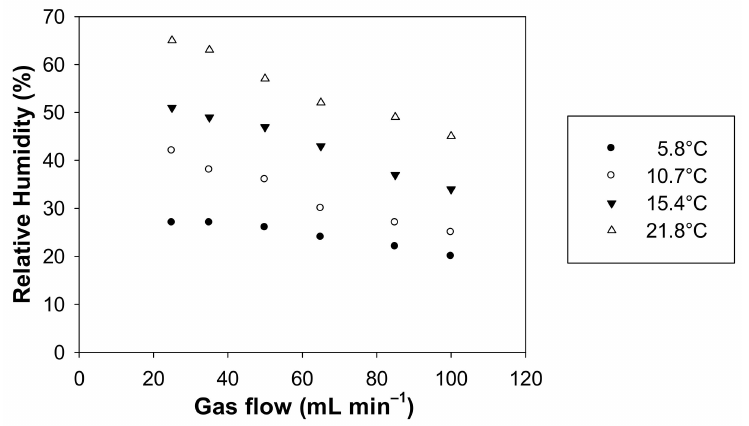
Figure 7. Relative humidity measured with the formaldehyde analyser ( µ F1, Chromatotec, Val-de- Virv é e, France) vs. the gas flow rate applied in the microporous tube using pure water. T = 5.8, 10.7, 15.4 and 21.8 ◦ C, F gas = 25, 50, 60, 80 and 100 mL min − 1 .